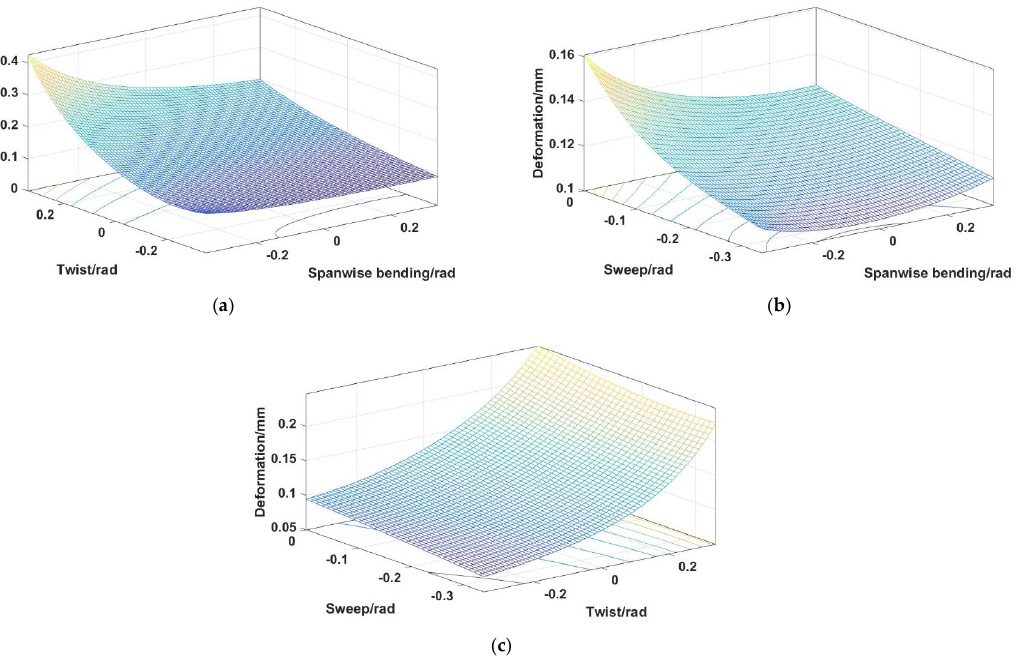
Figure 18. The relationship between the deformation of the 4SPS-RS parallel mechanism and sweep, twist, spanwise bending at the maximum span: ( a ) the relationship between the deformation and twist, spanwise bending; ( b ) the relationship between the deformation and sweep, spanwise bend- ing; ( c ) the relationship between the deformation and sweep, twist.